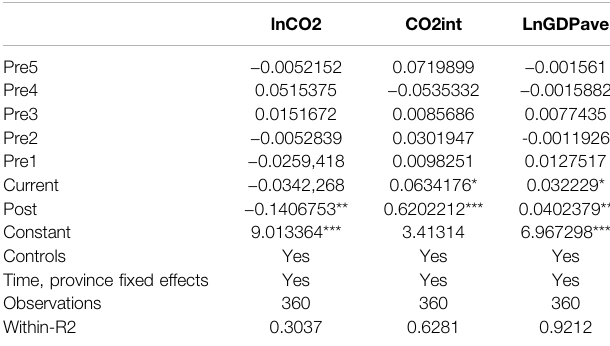
TABLE 3 | Parallel trend test